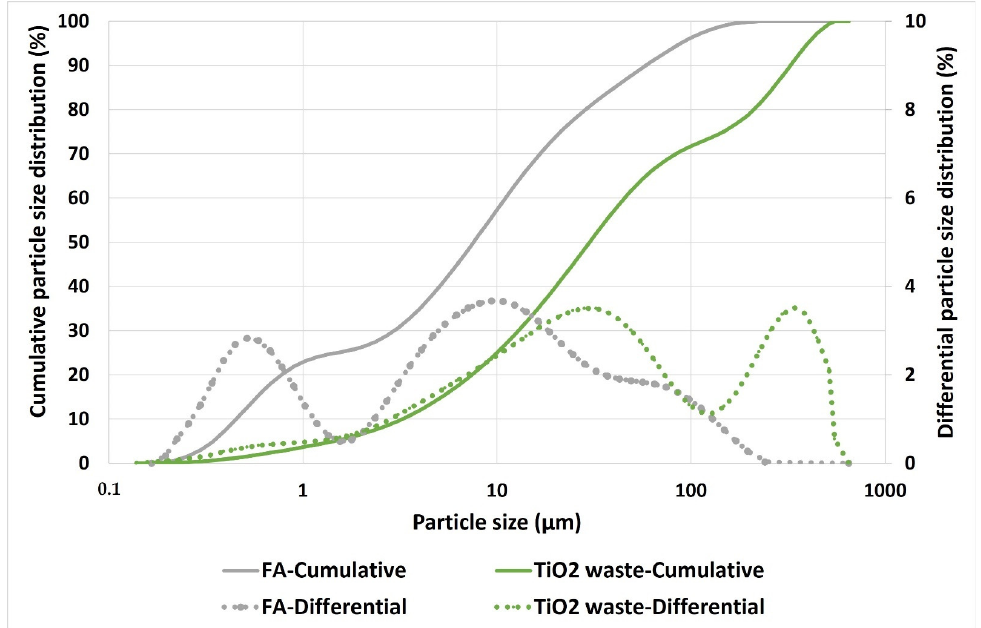
Figure 2. Particle size distribution of FA and TiO 2 waste.